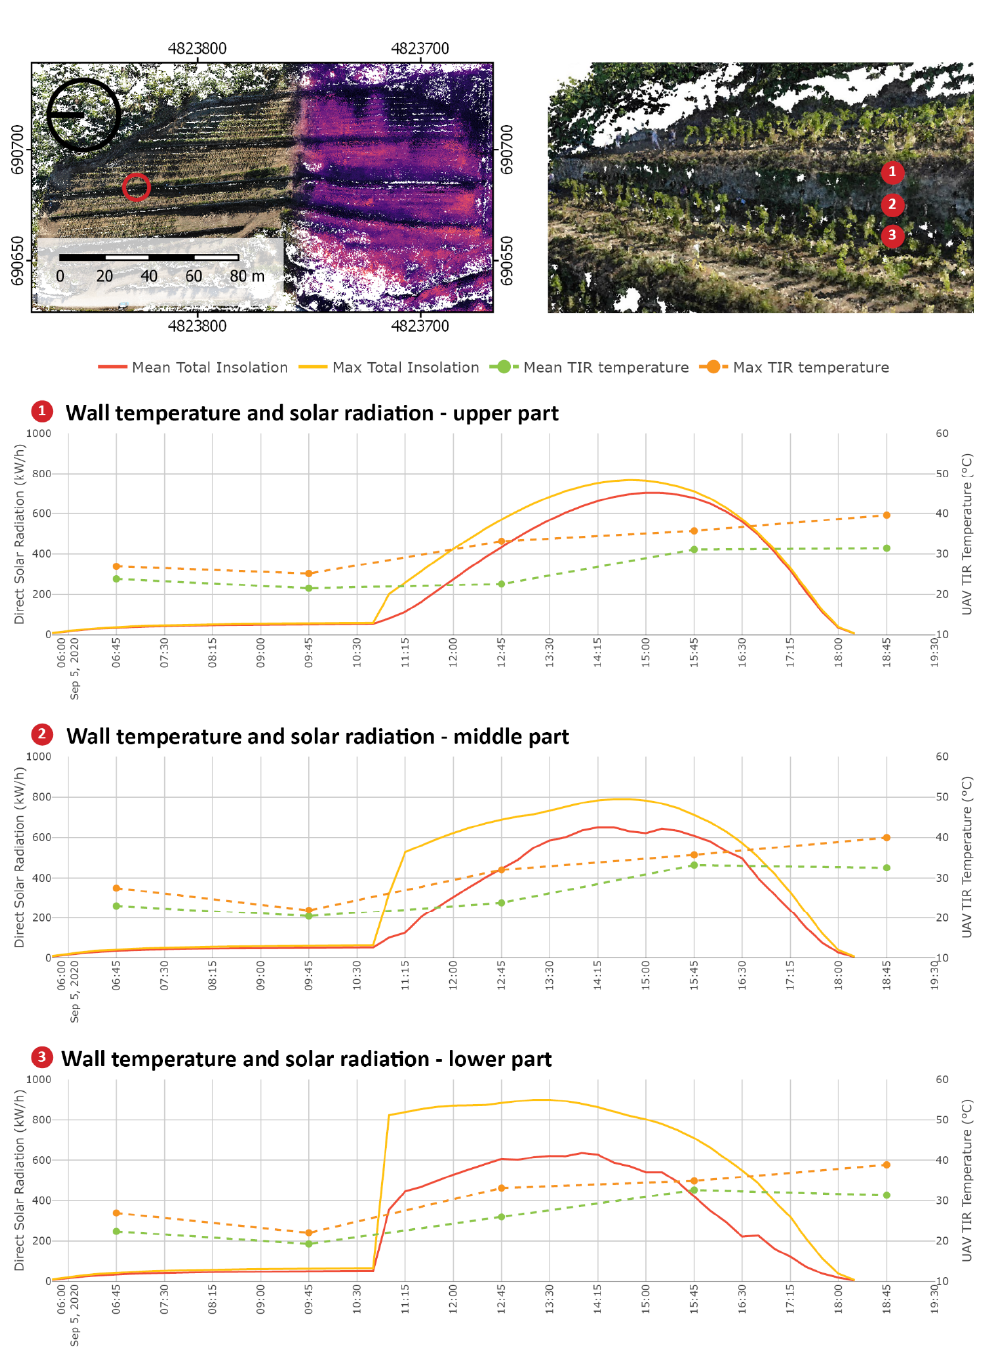
Figure 9. Graphs show the relation between daily temperature variation (DTV) and simulated solar radiation of a dry-stone wall. In the top view of the voxel model, red circle marks the exact location in the vineyard where the samples for the graphs were taken. Three-dimensional view of this location shows parts of the dry-stone wall chosen for the comparison marked with